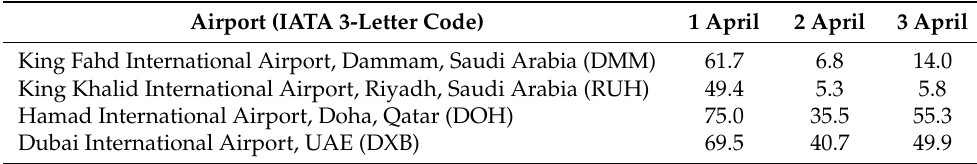
Table 3. Daily overall on time performance (OTP) at four international airports during the April 2015 dust storm